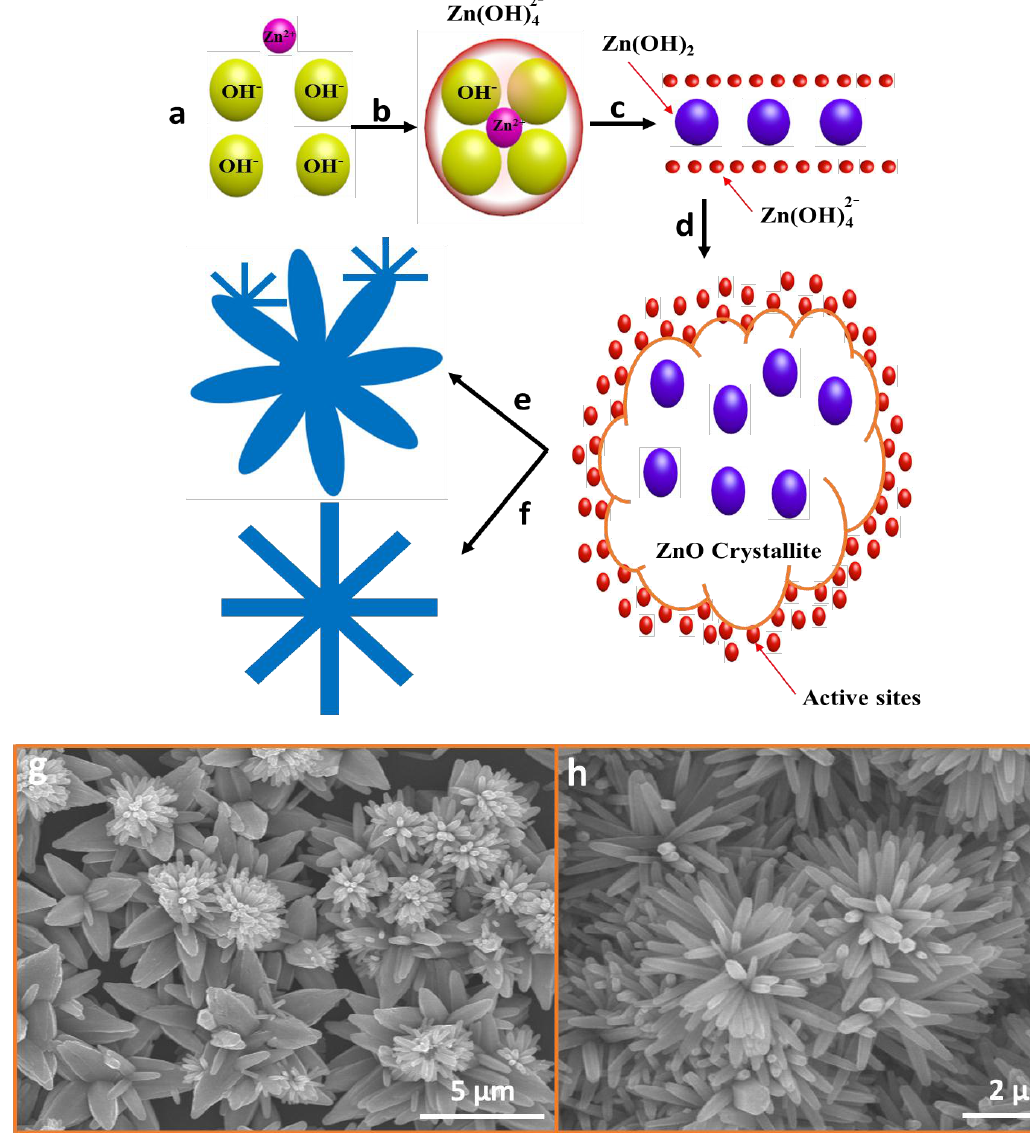
Figure 3. ( a – f ) Process flow for ZnO nanoflowers (ZNFs) growth using the ACG and MAG methods, ( g ) SEM image of ZNF using the ACG method, and ( h ) SEM image of ZNF using the MAG method.